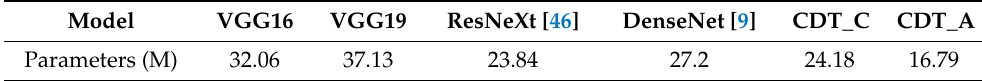
Table 4. Parameters of CDTNet and classical models.